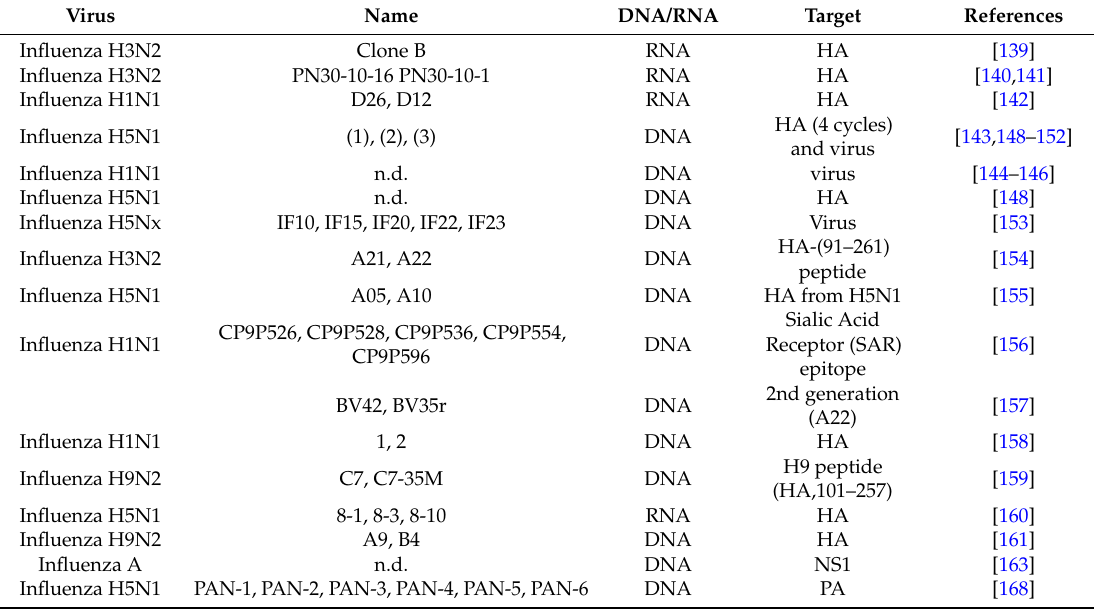
Table 6. Summary data on the aptamers selected against influenza virus discussed